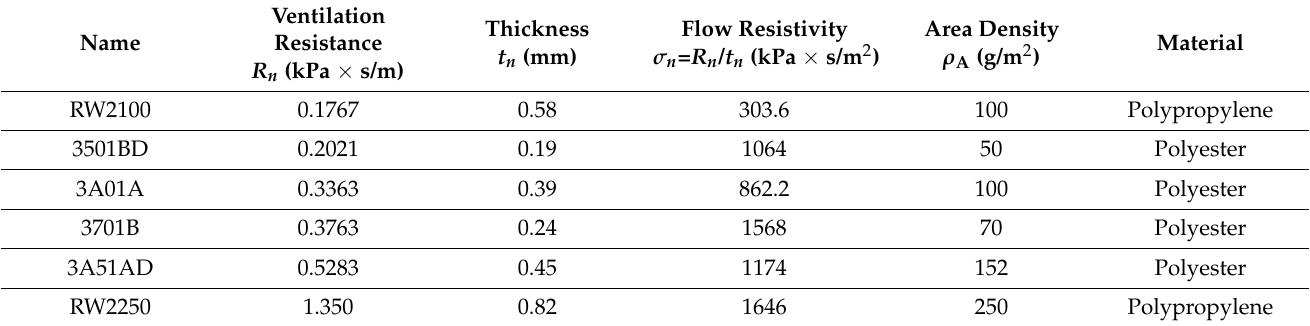
Table 1. Specifications of nonwoven fabrics.